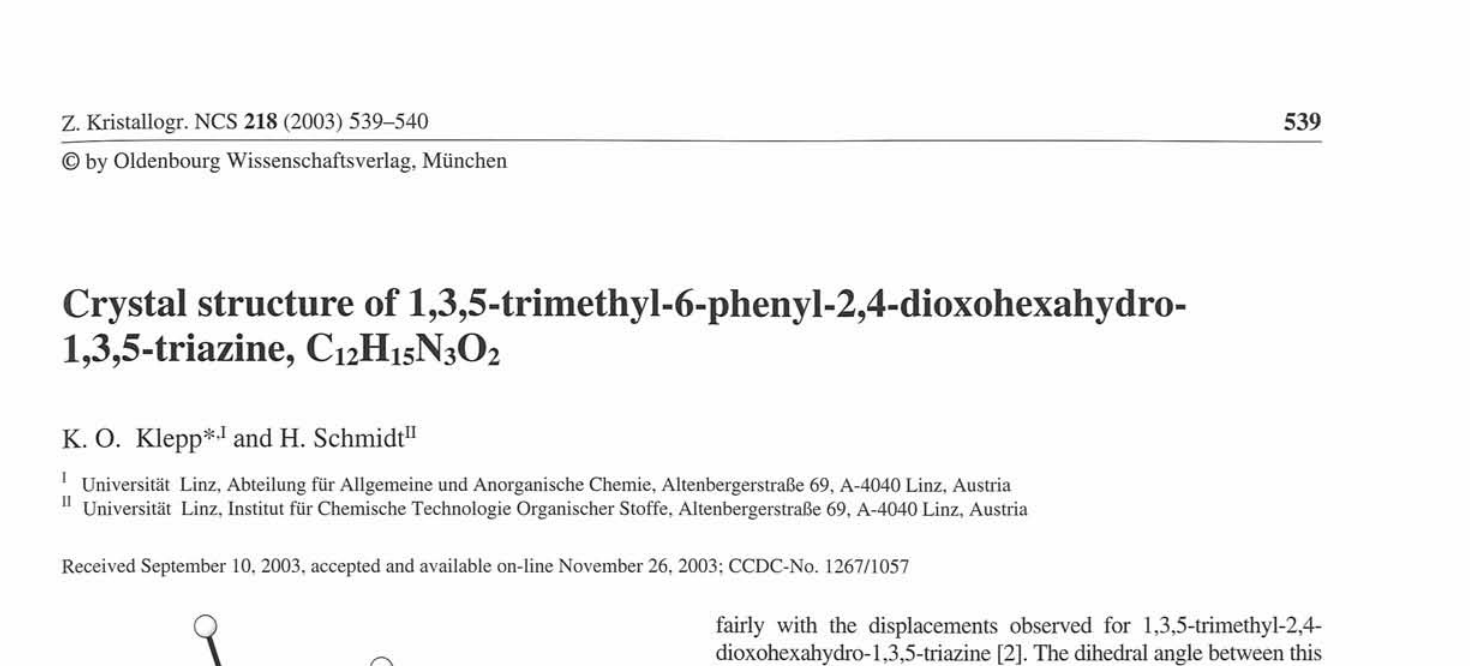
Table 1. Data collection and handling.